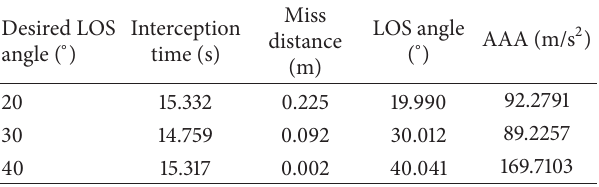
Table 9: Summary of simulation results with different impact